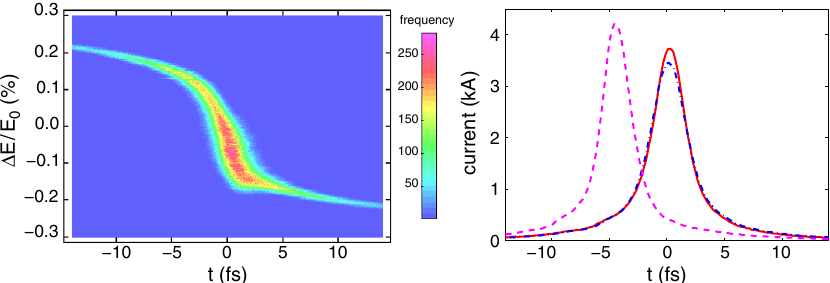
FIG. 3. (left) Longitudinal phase space for the overcompressed beam (bunch head to the left). (right) Temporal profiles: true temporal profile (red solid line); predicted temporal profile without considering ISR and CSR effect (blue dash-dotted line); predicted temporal profile with ISR and CSR taken into account (magenta dashed line).